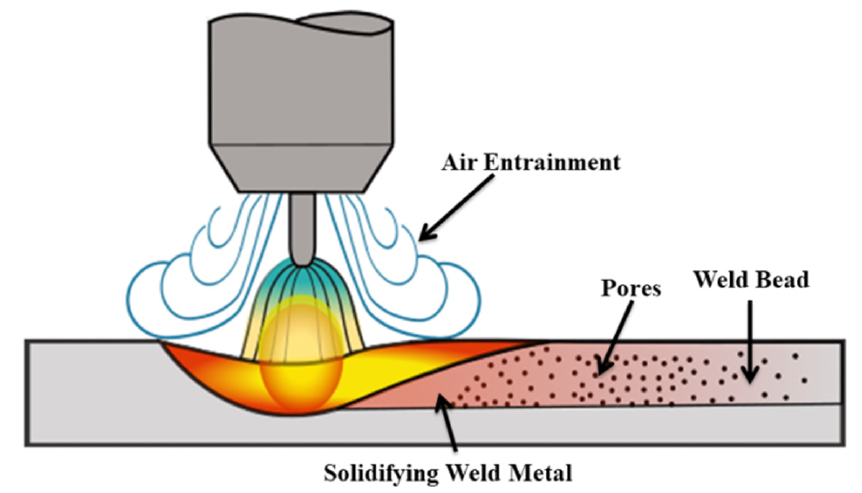
Figure 14. A schematic showing the emergence of porosity in welding.